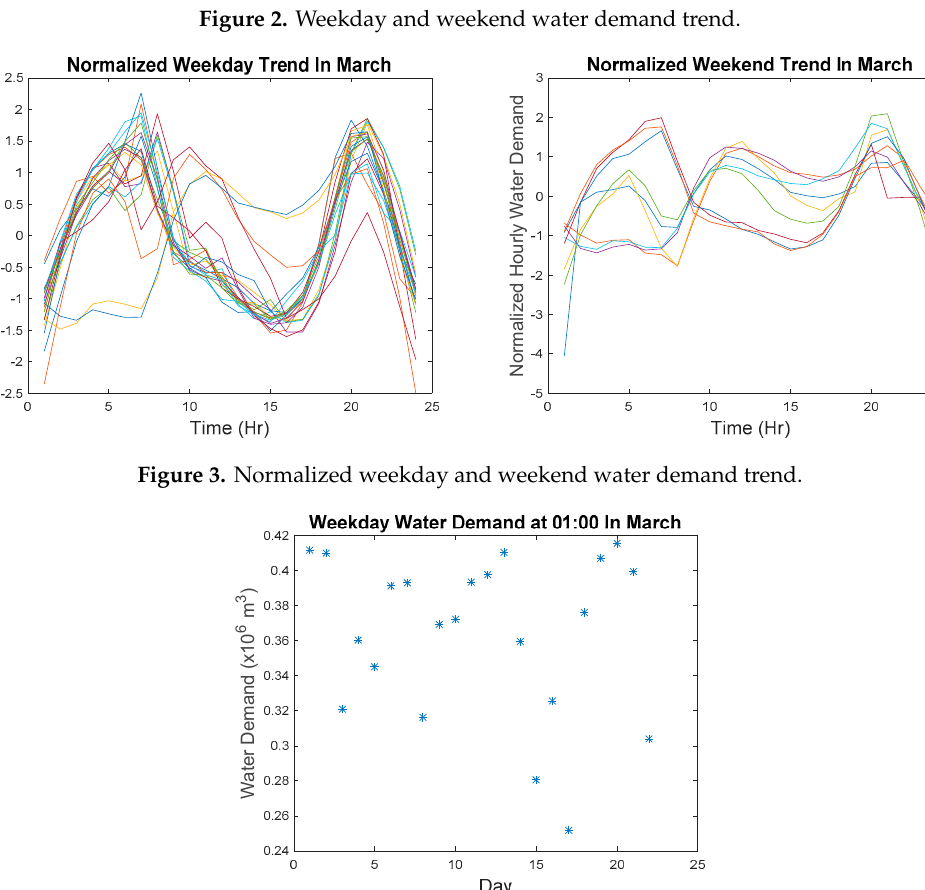
Figure 4. Weekday water demand at 01:00 in March.